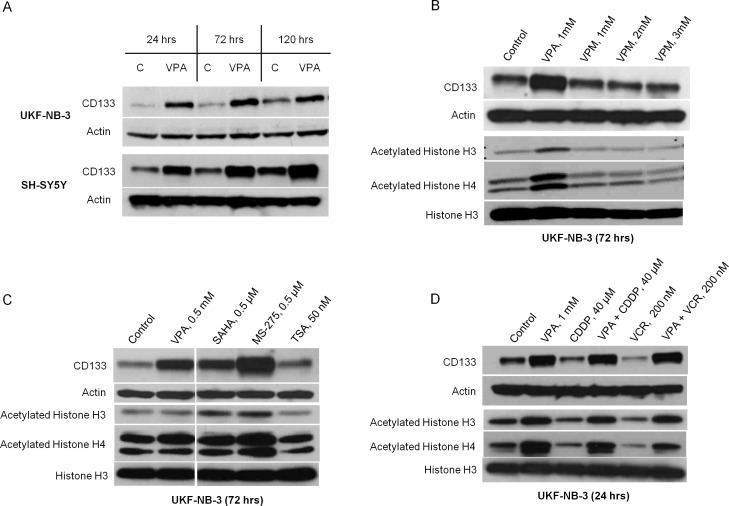
Changes of CD133 expression and histones H3 and H4 acetylation in UKF-NB-3 and SH-SY5Y after cultivation with 1mM VPA, valpromide, other HDAC inhibitors and cytostatics.(A) VPA increased CD133 expression in UKF-NB-3 and SH-SY5Y. (B) VPM failed to influence CD133 expression or histone acetylation after cultivation with non-toxic doses for 72 hrs. (C) CD133 expression correlated with the changes of histones H3 and H4 acetylation when cultured with different HDAC inhibitors. (D) CD133 expression correlated with the changes of histones H3 and H4 acetylation when cultured with high doses of CDDP or VCR and in combination with VPA for 24 hrs.